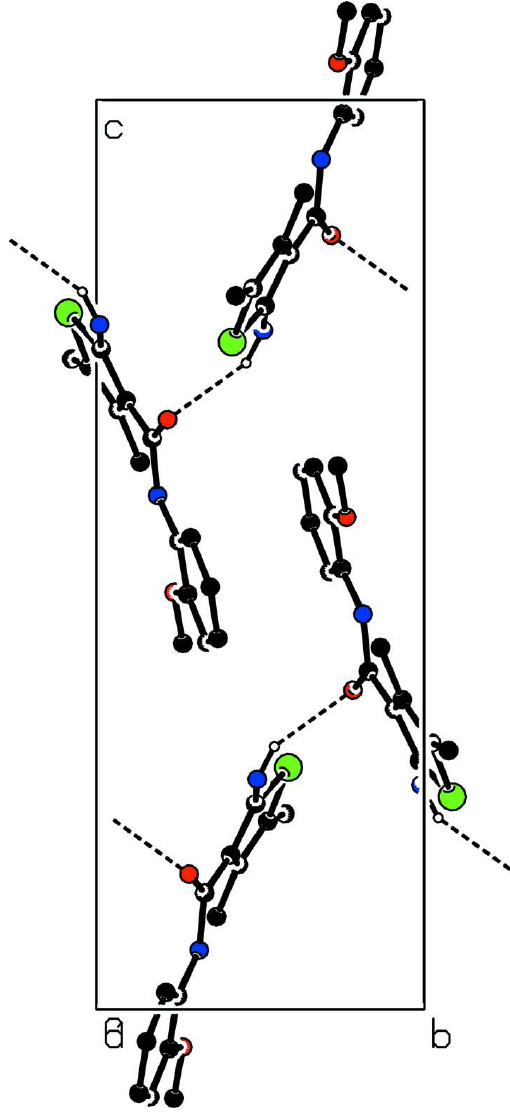
The packing of (I), viewed down the a axis shows molecules connected by N—H···O hydrogen bonds (dashedlines). H atoms not involved in hydrogen bonding have been